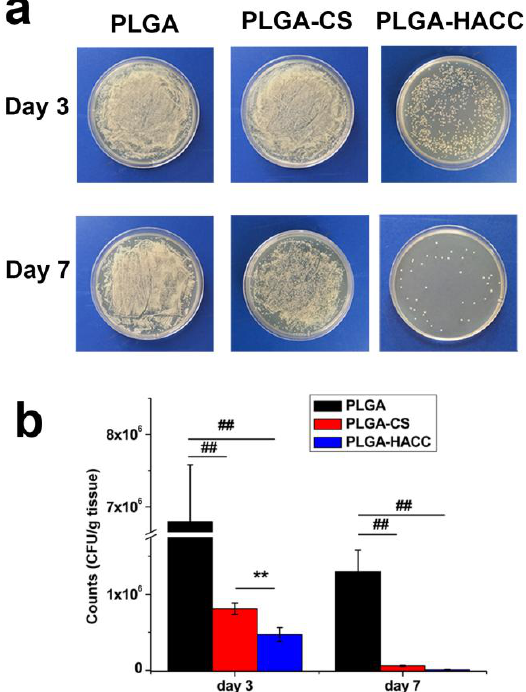
Figure 8. Bacteria separated from wound tissue were cultured on agar plates at Day 3 and Day 7 ( a ); The number of the surviving bacteria in the wound tissue of each sample ( b ); ## indicates p < 0.01, and ** indicates p < 0.05.